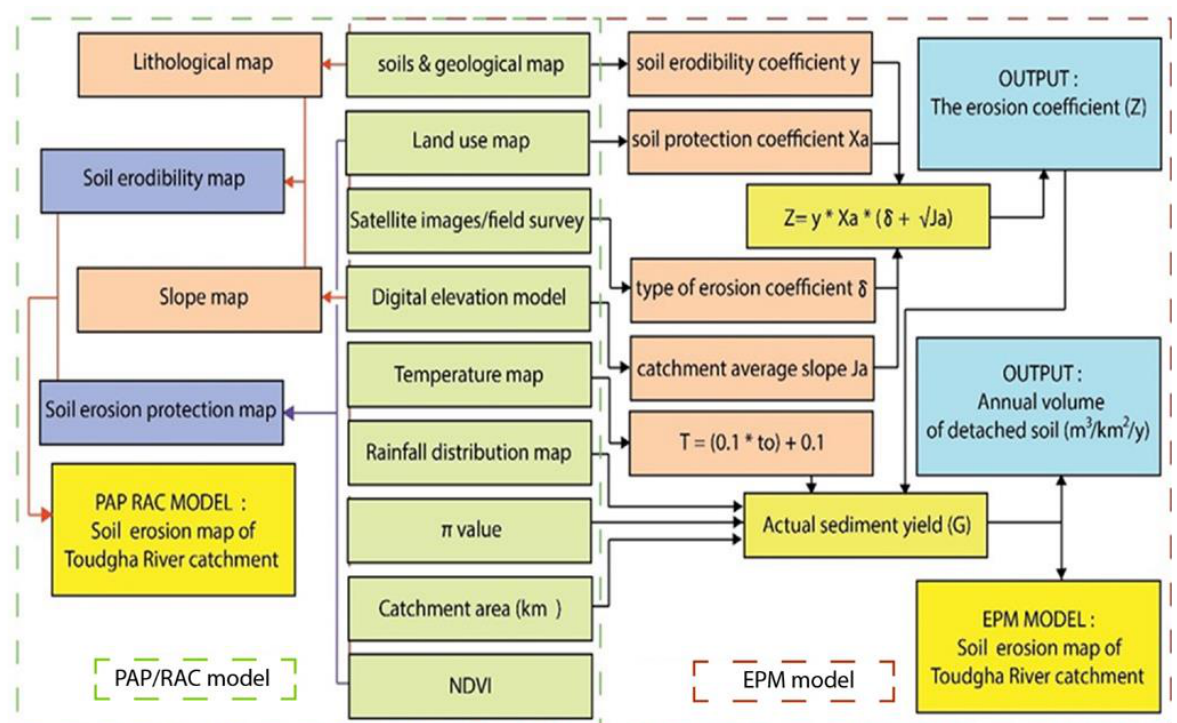
Figure 2. ( a ) Elevation classes and ( b ) slope degrees of the study area.